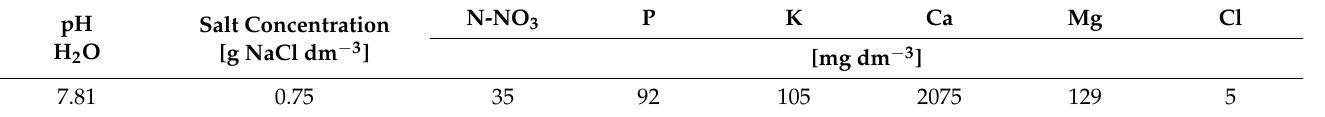
Table 1. Chemical properties of